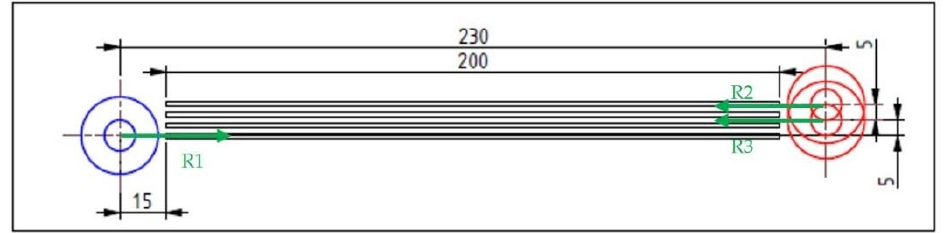
Figure 2. Chosen processing route—Advancing side of process run 1 (2) on the side of grooves (tool travel direction as well process run number is depicted by green arrow; rotation is in all cases clock-wise).